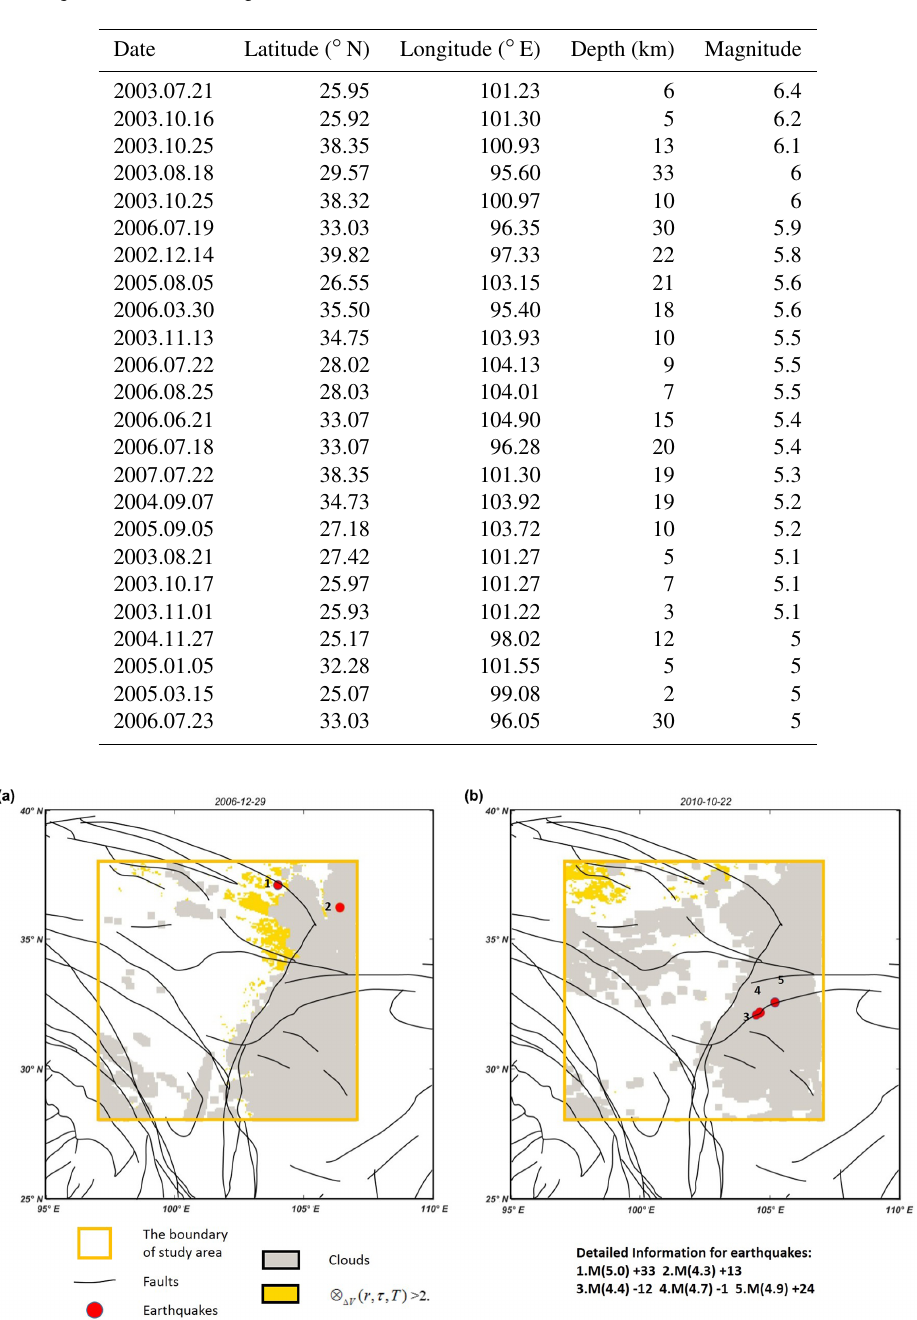
Table 1. Catalog of earthquakes with M ≥ 50 prior to 2008.